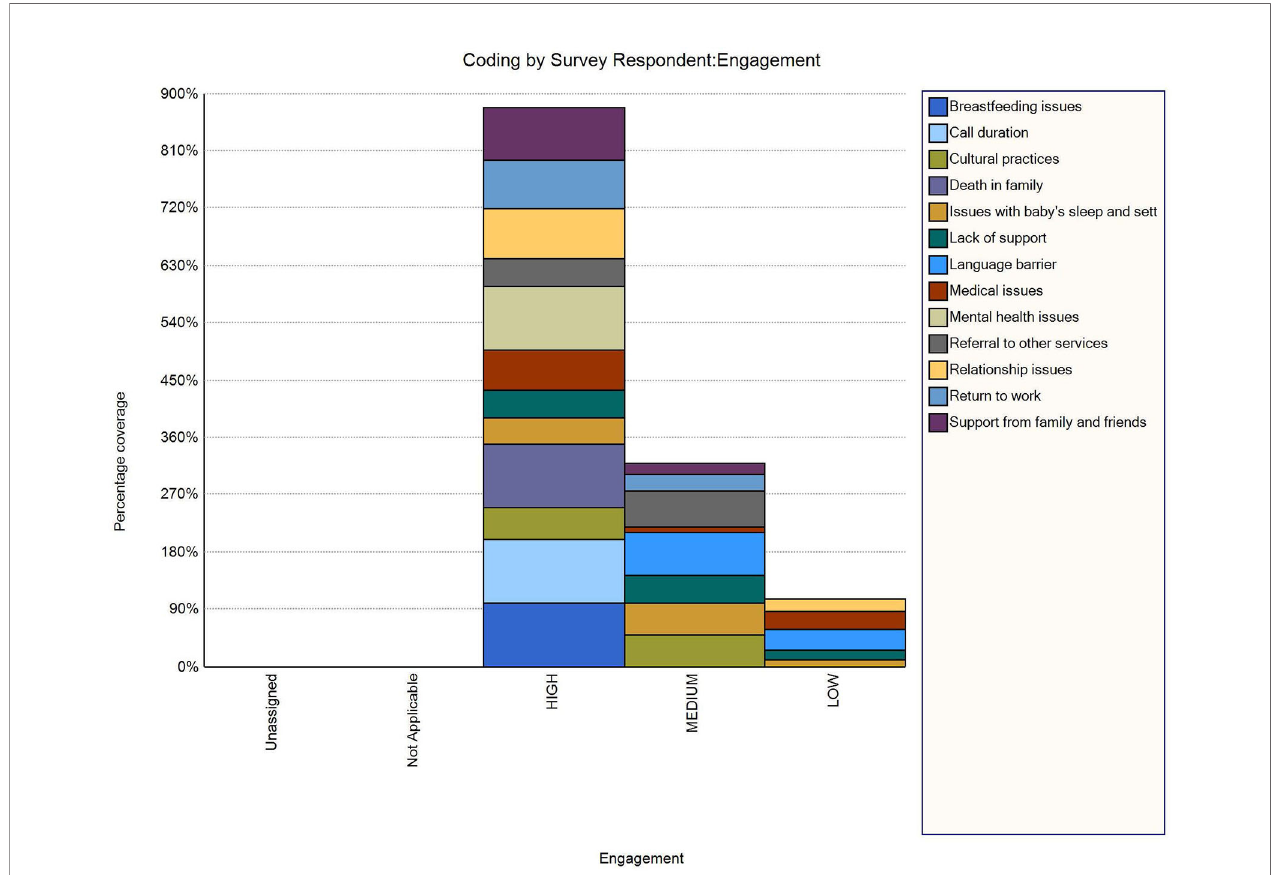
FIGURE 2 | Representation of issues discussed during intervention provision by participants ’ engagement level and as recorded by intervention providers who delivered telephone